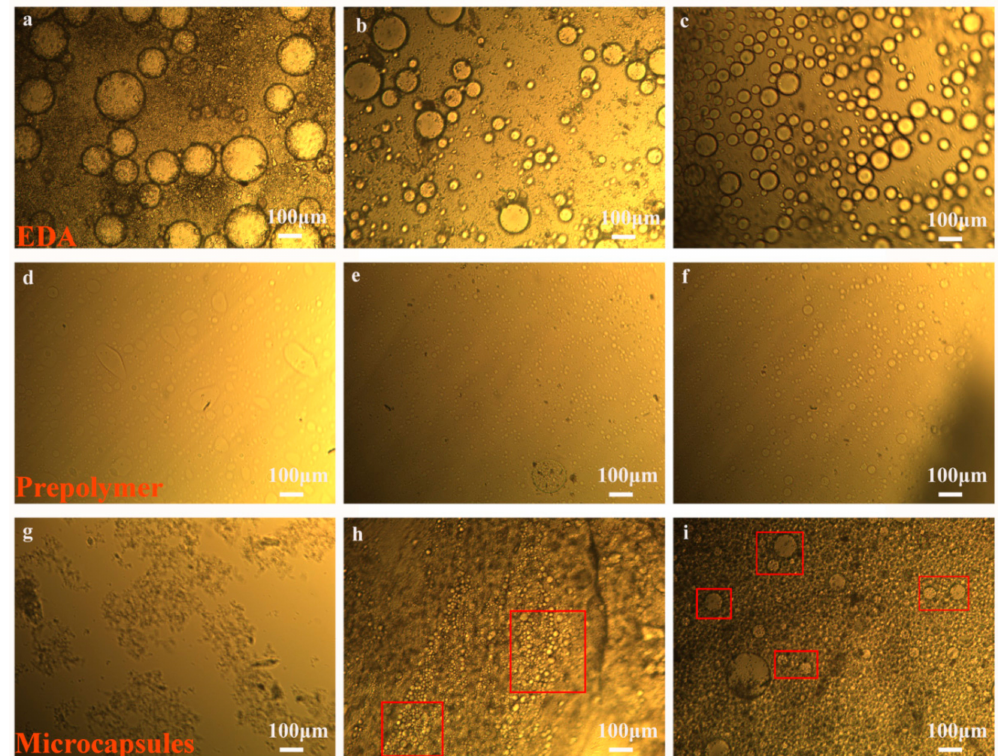
Figure 3. OM morphology of the microcapsules with di ff erent stirring rates: microcapsules ( g ) were obtained with EDA ( a ) at 1000 rpm and polymer ( d ) at 1500 rpm; microcapsules ( h ) were obtained with EDA ( b ) at 1500 rpm and polymer ( e ) at 2000 rpm; microcapsules ( i ) were obtained with EDA ( c ) at 2000 rpm and polymer ( f ) at 2000 rpm.